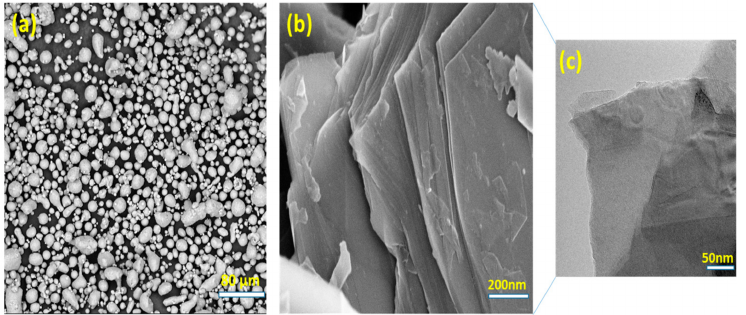
Figure 2. SEM images of the raw materials: ( a ) Pure Al powder and ( b ) graphene nanoplatelets (GNPs) and ( c ) TEM image of the